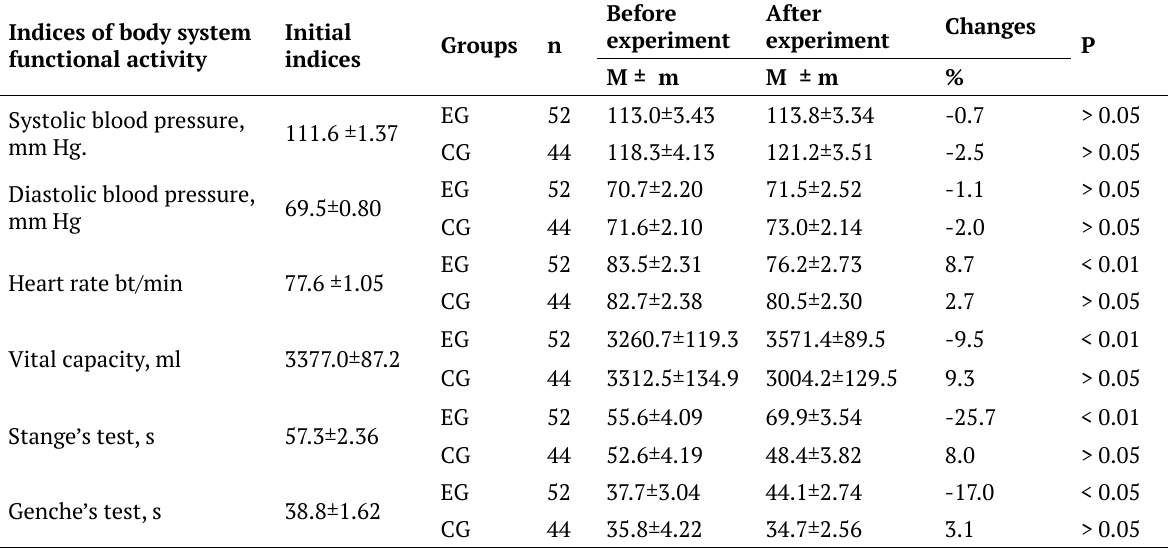
Table 2. Comparative characteristics of functional fitness indices of the 1st year students of CG and EG before and after the pedagogical experiment Indices of body system functional activity Systolic blood pressure, Diastolic blood